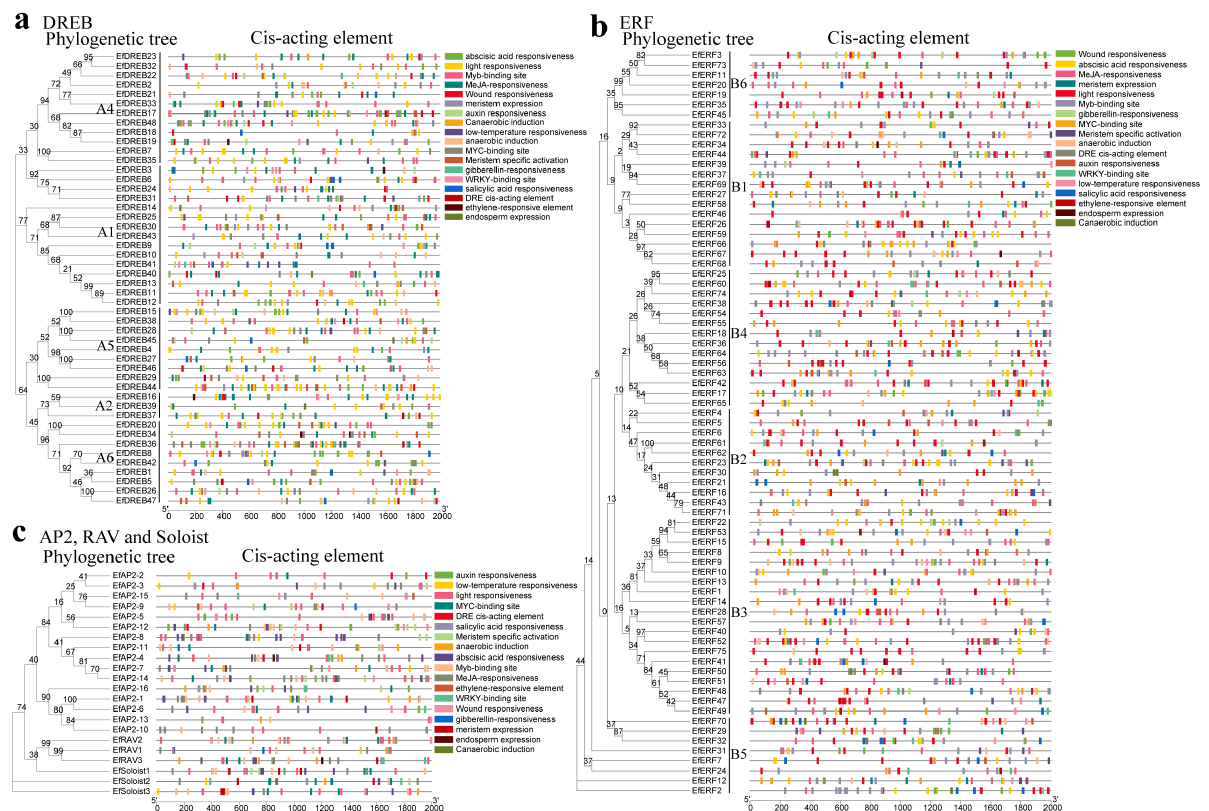
Figure 8. Promoter cis-acting element analysis of EfAP2/ERF family genes according to phylogenetic relationship. ( a ) Cis-acting element of EfDREB subfamily. ( b ) Cis-acting element of EfERF subfamily. ( c ) Cis-acting element of EfAP2 , EfRAV , and EfSoloist subfamilies. Each cis-acting element is displayed in different-colored